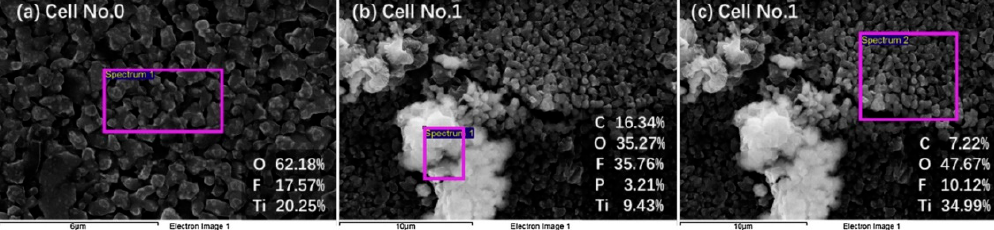
Figure 8. Energy dispersive spectrometer results. ( a ) Fresh cell anode; ( b ) degraded cell anode deposits; ( c ) degraded cell anode [75].